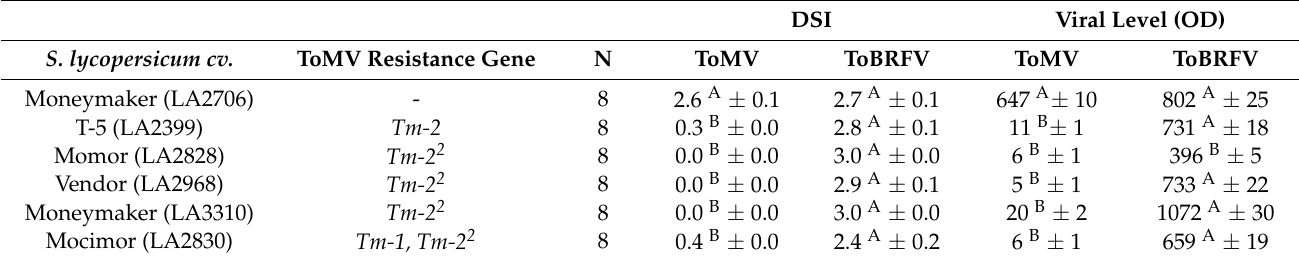
Results are presented as Mean ± Standard Error, viral level was determined by ELISA using specific antibodies for each tested virus and is presented as optical-density (OD) × 1000, N denotes number of plants, and different superscript letters above means express a statistically significant difference, P < 0.05, based on Tukey-Kramer Honestly Significant Difference (HSD)